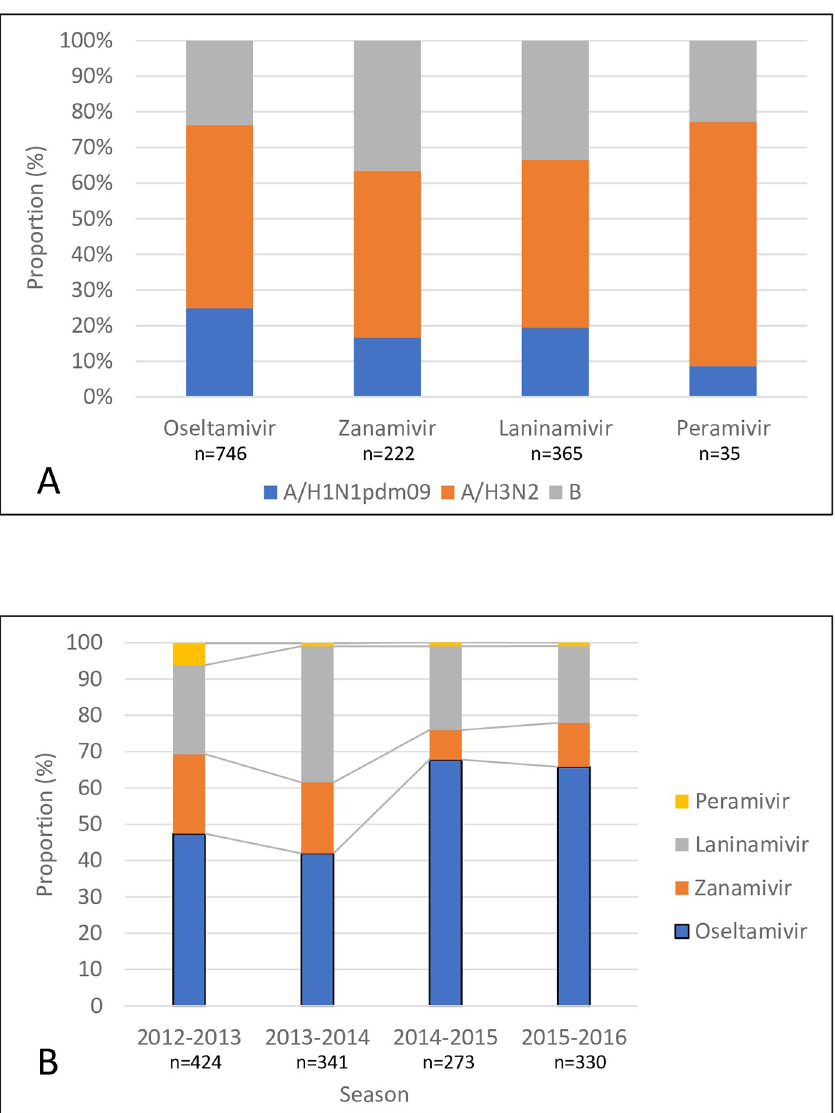
Fig 2. Variation of type/subtype of influenza virus in each NAI treatment group and selection of NAIs by season. A: Proportion of type/subtype of influenza virus in each NAI treatment group. B: Proportion of each NAI treatment group by season. NAI, neuraminidase